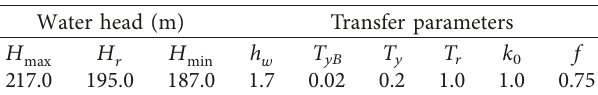
Figure 4: Hydraulic-mechanical-electrical coupling model. Table 1: Water head and parameters of simulation model of a Table 3: The ITAE value of the output frequency ITAE _f when power station. Δ f � − 0 . 5Hz.